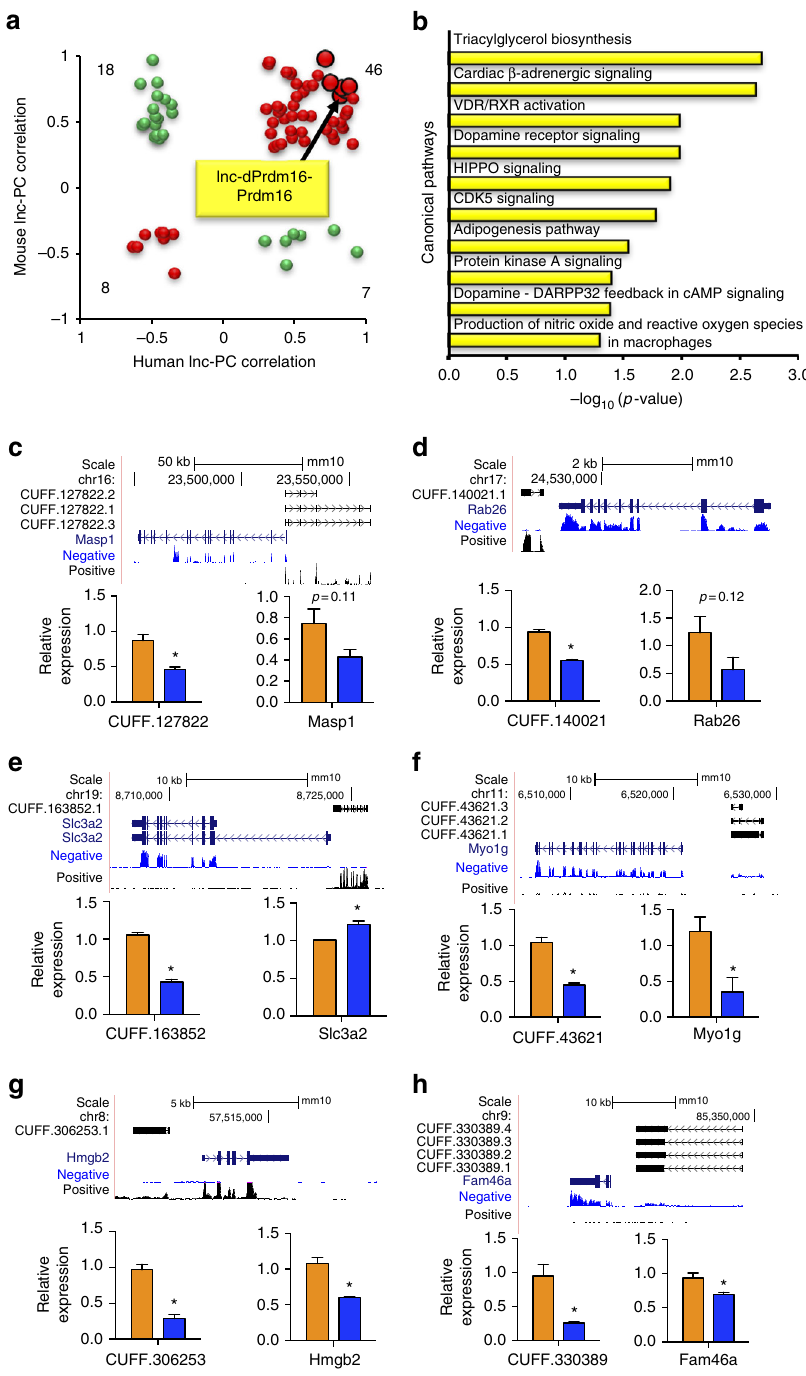
Fig. 6 Regulatory interactions between lncRNAs and their nearby mRNAs. a Scatterplot of lncRNA – mRNA correlations in mouse against those in human. Only correlation values of at least 0.3 in both species are included in the plot. In all, 54 out of 79 pairs (red dots) show conserved correlations between mouse and human. Binomial test, p -value = 0.001466. b Top enriched gene ontology terms of the protein-coding genes extracted from the upper right quadrant of a . c – h siRNA knockdown of six selected lncRNAs in brown pre-adipocytes followed by 4 days of differentiation. Real-time PCR was performed to detect the knockdown ef fi ciency and the expression change of their nearby mRNAs. Gene expression was normalized to RPL23 as the housekeeping gene. Error bars represent mean ± SEM, n = 3, * p < 0.05, Student ’ s T lncRNAs and 19.5% of mouse lncRNAs) were identi fi ed, sug- gesting that majority of the lncRNAs are species-speci fi c. Between conserved and non-conserved lncRNAs, there was no apparent difference in exon (Supplementary Fig. 5B) and isoform (Sup- plementary Fig. 5C) distributions, gene expression (Supplemen- tary Fig. 5D), variation (Supplementary Fig. 5E), and correlation